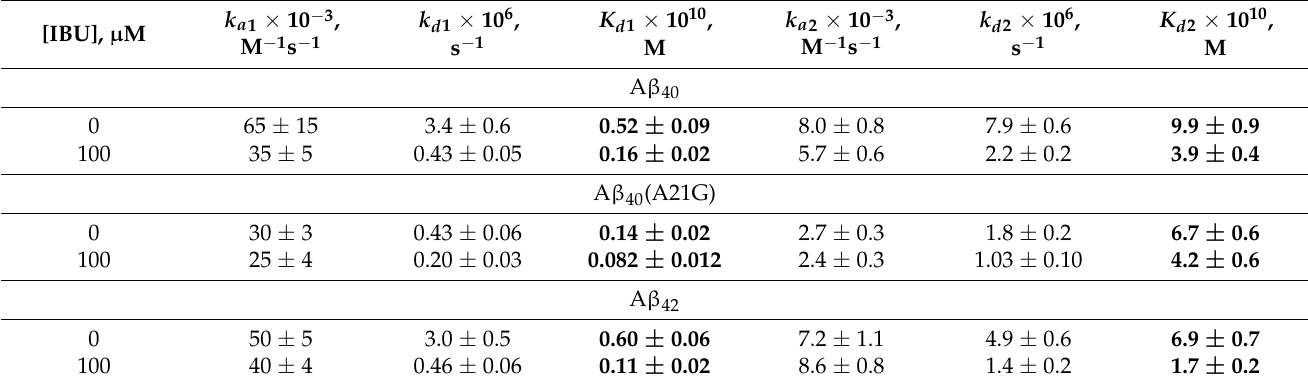
Table 1. Parameters of the heterogeneous ligand model (1) describing the SPR data on kinetics of the HSA–A β interaction in the absence or presence of IBU (see Figure